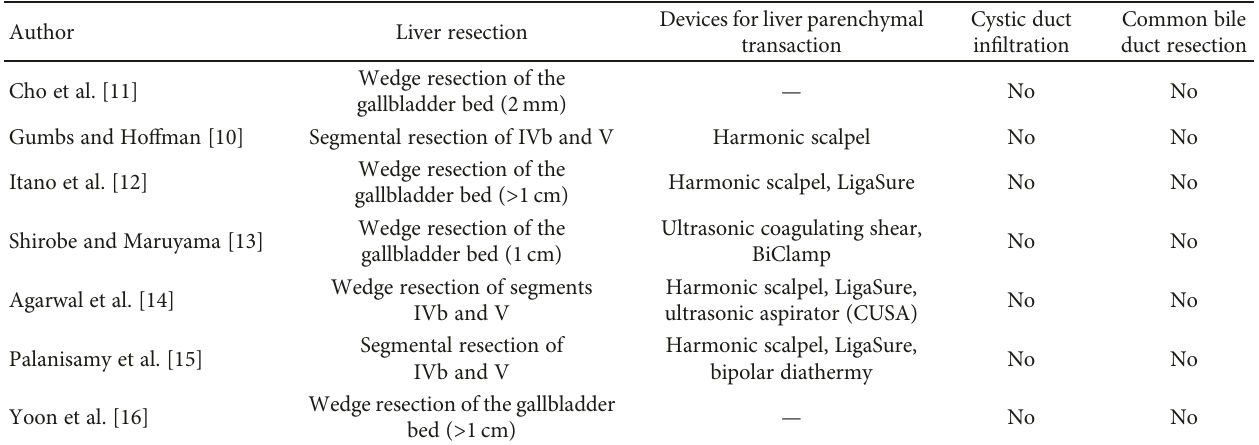
Table 3: Primary GBC surgery details.